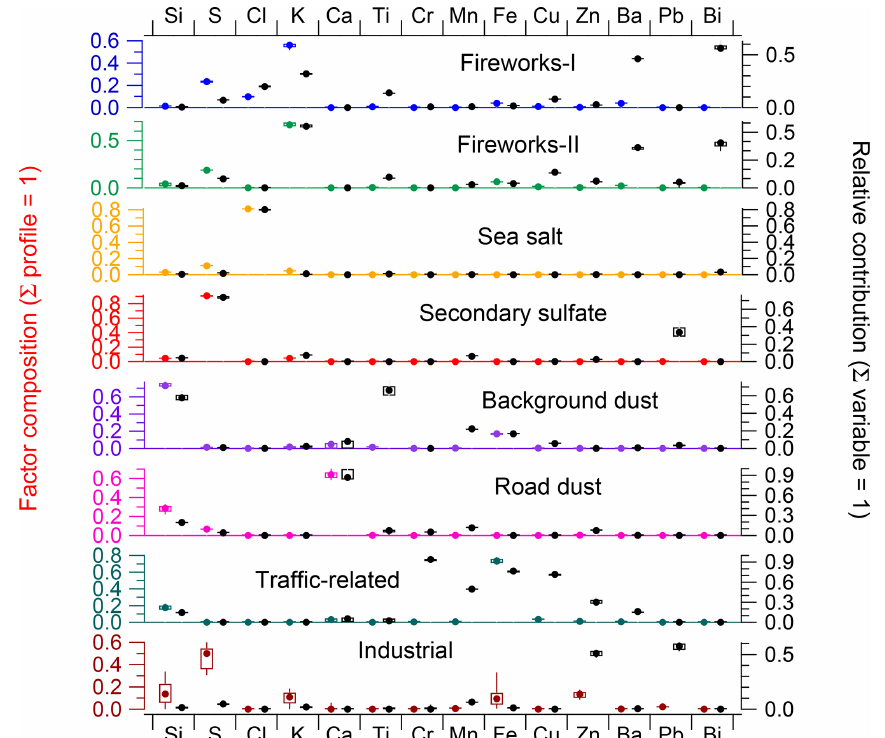
Figure 2. Source profiles of the finally retained eight-factor PMF results. The data and their corresponding uncertainty are given as box– whisker plot (bottom to top: p10–p25–p50–p75–p90) of good solutions from bootstrap runs. The left y axis represents the fractional com- position of the factor profile row-wise (presented in coloured box–whisker plot) for each factor (in ngng − 1 ); the right y axis represents the relative contribution of each factor to each variable (indicated in black box–whisker plot).